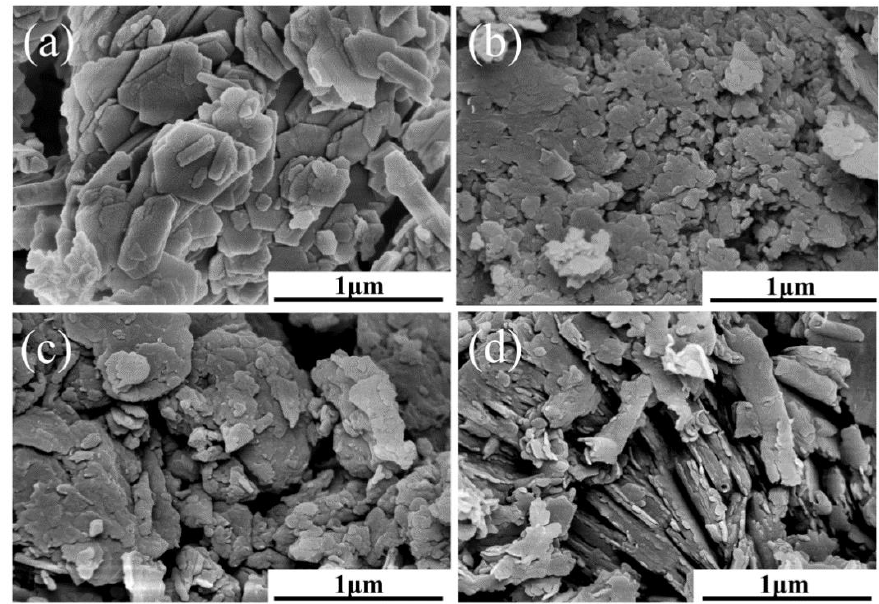
Figure 2. SEM images of ( a ) KA, ( b ) CN, ( c ) CN/KA composite, ( d ) m-CN/KA-4 composite.